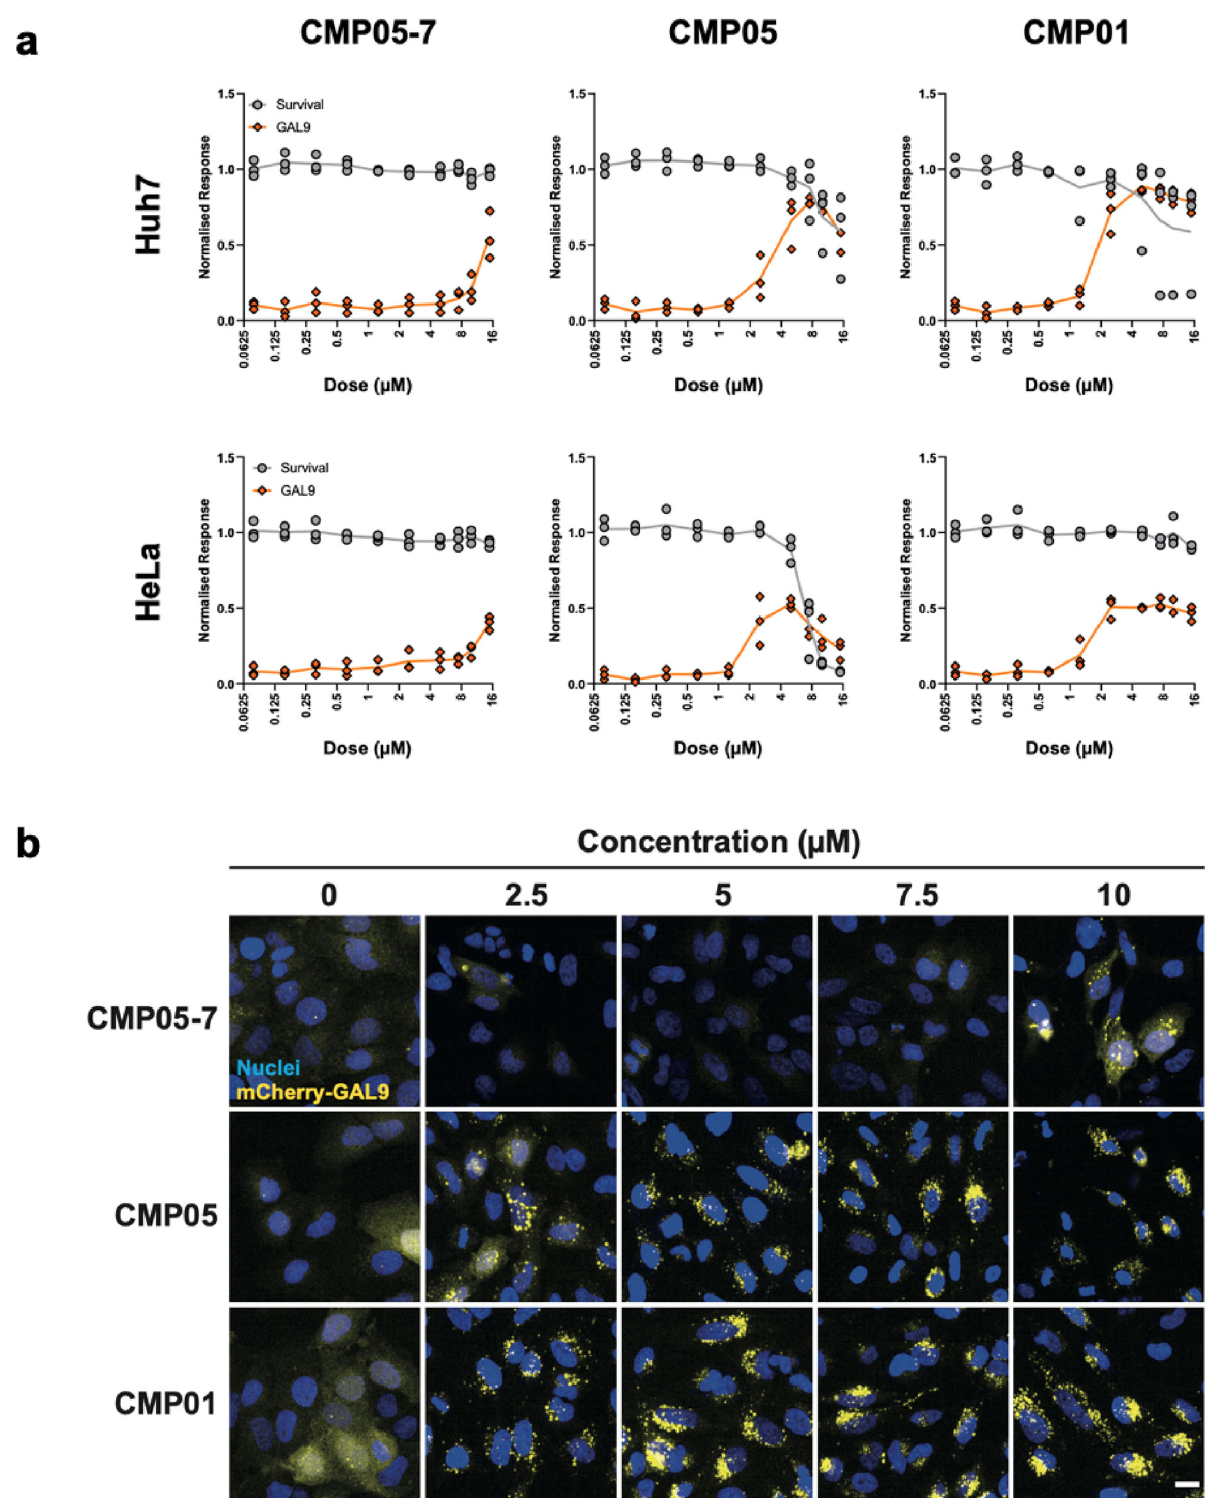
Fig. 2 Screening endosomolytic compounds for Gal9-related endosomal rupture. a HeLa_mCherry-Gal9 cells were treated with compound across 10-point dose titration series for 2 h and then stained for nuclei (Hoechst 33342, blue), fi xed, and imaged. Representative images display the translocation of Gal9 (yellow) from cytosolic to punctate in a dose-dependent manner. Scale bar = 20 µ m. b Image analysis reveals the narrow window in concentration between induction of endosomal rupture and cytotoxicity. Gal9 punctate (orange) reported as a percentage of max quantitation, normalized to nuclei signal. Cell survival (gray) reported as a percentage of all cells normalized to a DMSO control. HuH7 images are shown in Supplementary Fig.